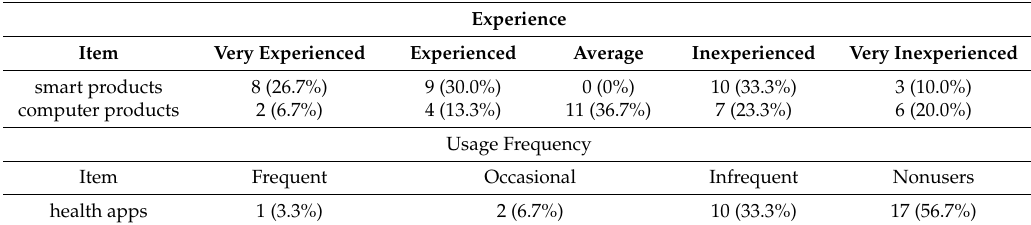
Table 4. Respondents’ experiences and usage frequency for relative products and apps.